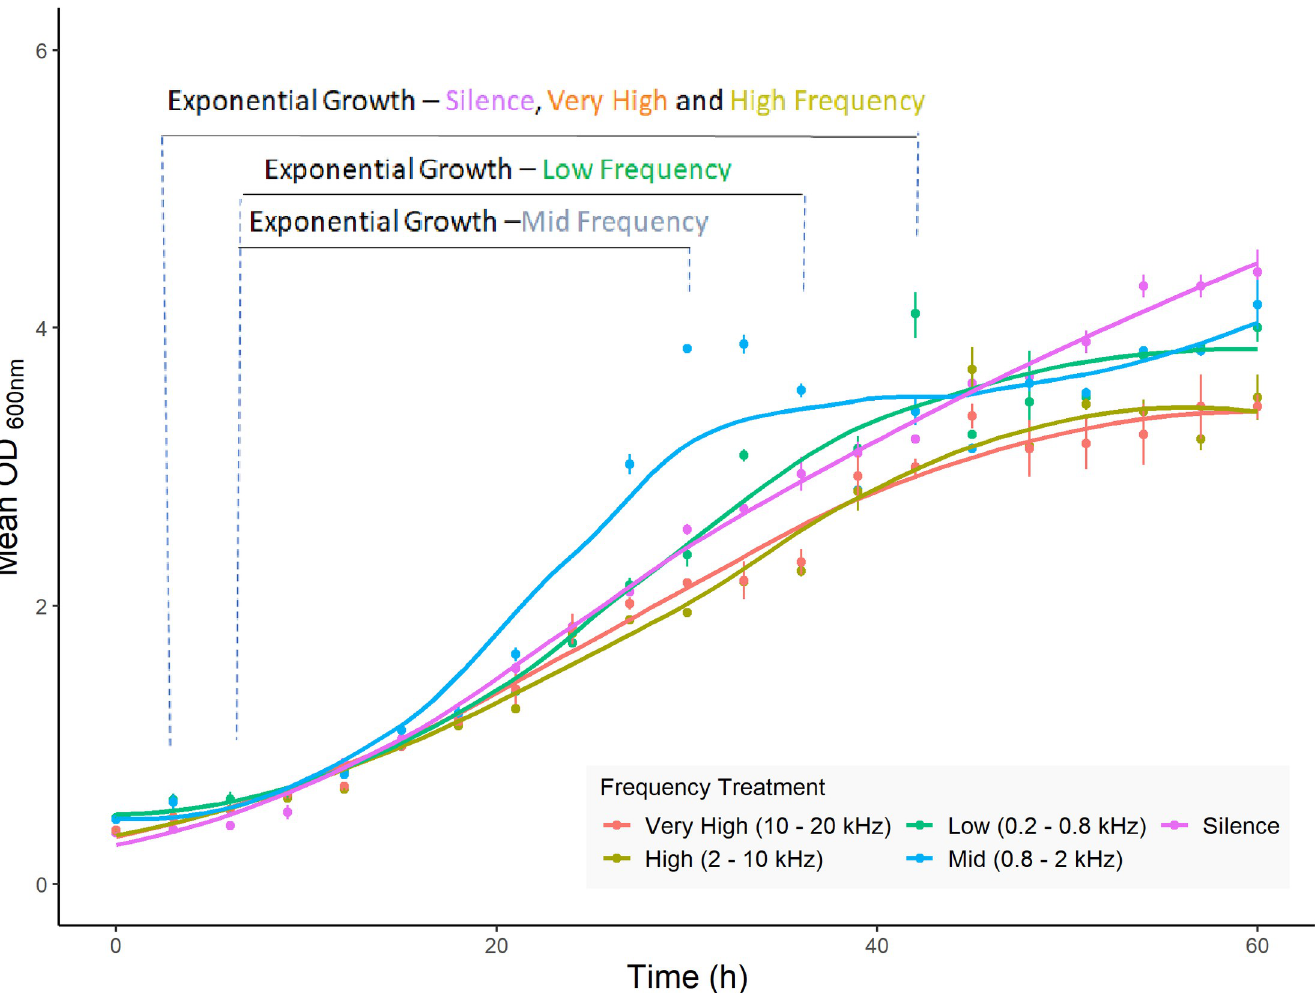
Fig 3. Growth curves of S . cerevisiae US05 exposed to different sound treatments. Fermentations were performed at 25˚ C using a minimal medium with 105 g L -1 maltose. Biological replicates were subjected to five sound treatments; silence (purple), low frequency (green), mid frequency (blue), high frequency (yellow), and very high frequency (red). Each data point represents the mean of biological replicates (n = 3), with standard deviation represented by error bars. The curves represent the line of best fit for each sound treatment, with the exponential growth phase indicated. Fermentations exposed to low and mid frequency growth had a longer lag phase and shorter exponential growth phase than the other sound treatments and silence. See S1 Table for data used.